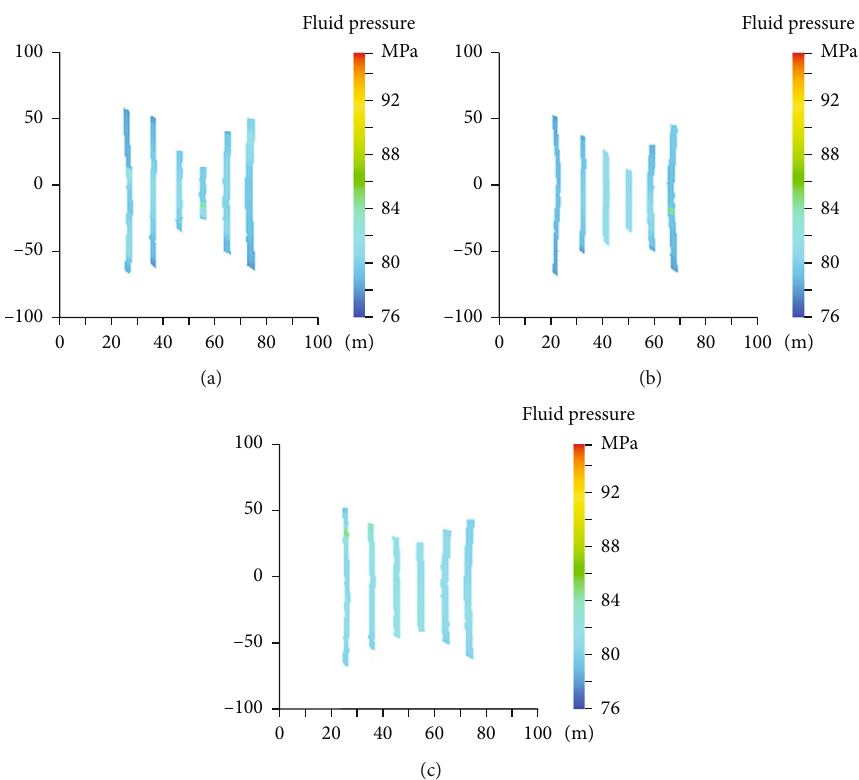
Figure 9: E ff ects of di ff erent fl ow rates on fracture geometry: (a) fl ow rate 9 m 3 /min, (b) fl ow rate 12m 3 /min, and (c) fl ow rate 15m 3 /min.